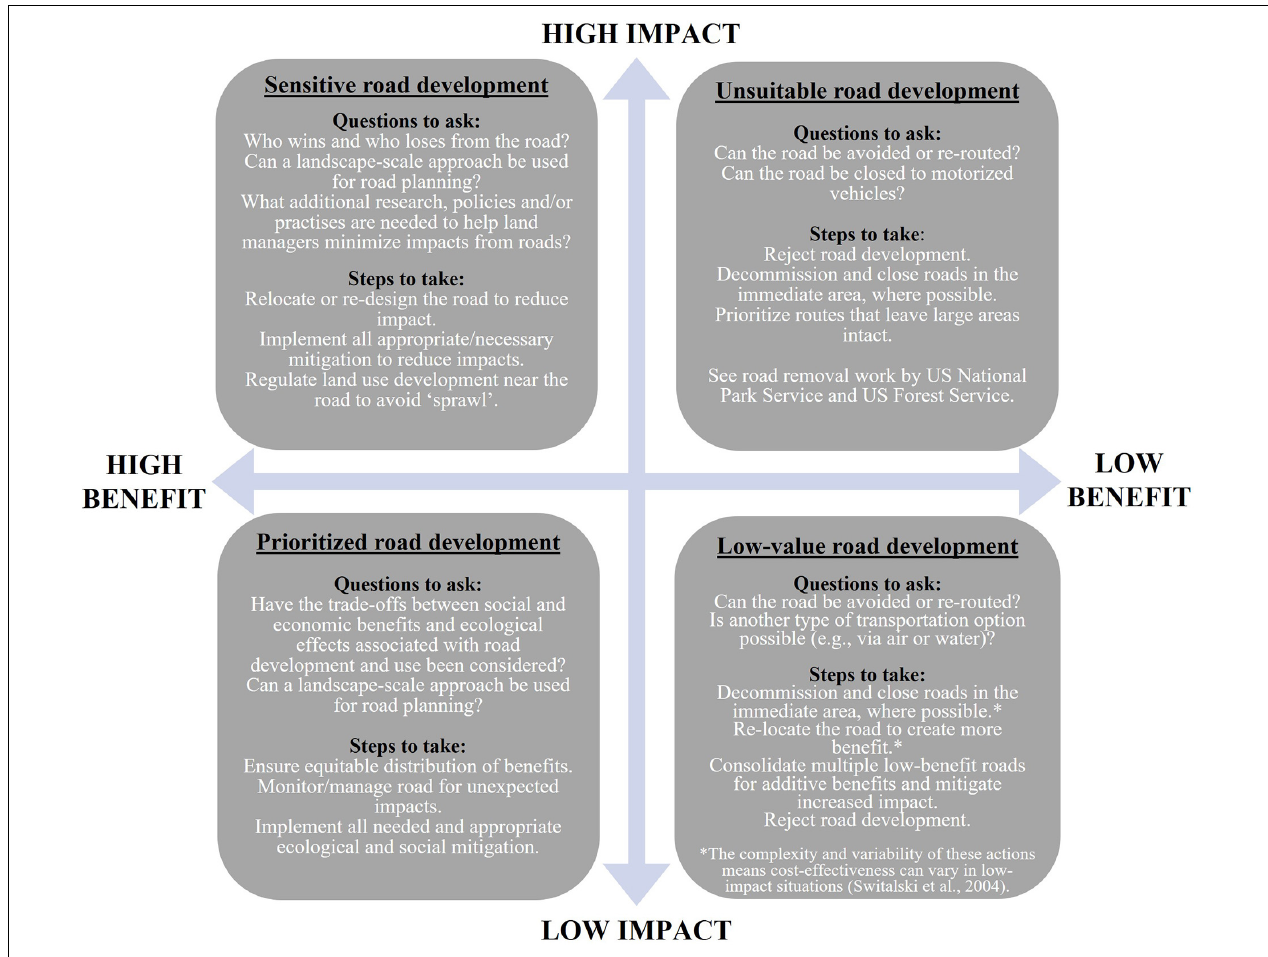
FIGURE 2 | Conceptual plan to portray a range of scenarios in road development, key questions to ask, and recommended steps to take in each scenario.